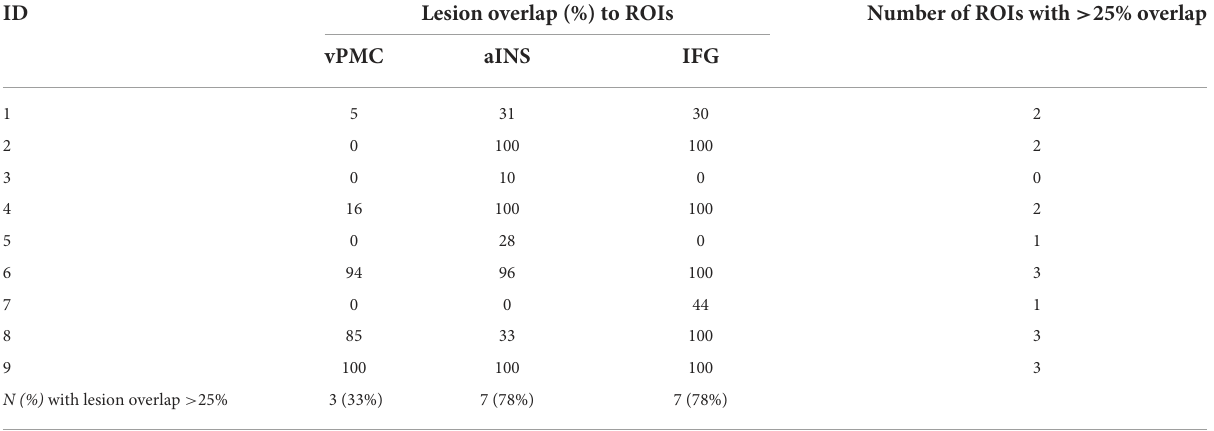
TABLE 4 Percentage lesion overlap with the selected ROIs in participants with AOS, aphasia, and NVOA. ID Lesion overlap (%) to